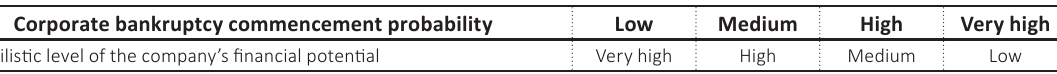
Source: Developed by the authors.